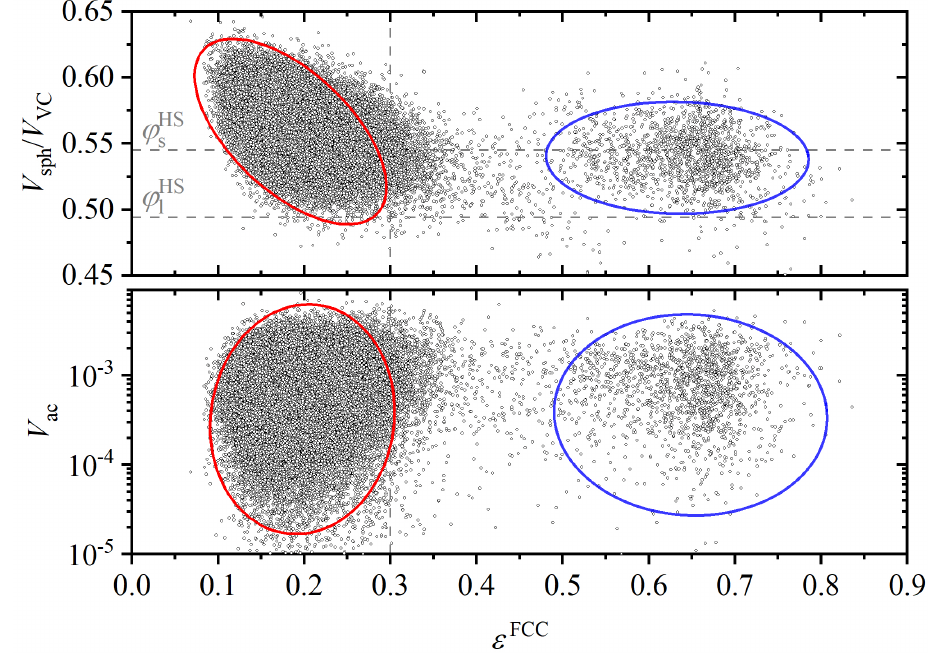
Figure 13. Parity plot of local volume fraction (upper panel) and accessible volume (bottom panel) at frame 14,000 in Region IV vs. the corresponding FCC-CCE norm, ε FCC . Red ellipse denotes FCC sites. Blue ellipse corresponds to non-FCC sites. Horizontal dashed lines in the upper panel mark the volume fractions of the liquid and solid phases of the monomeric HS fluid at equilibrium, i.e., = 0.494 and ϕ HS = 0.545, respectively. The vertical dashed line denotes the CCE-norm threshold ϕ HS s l ε thres =